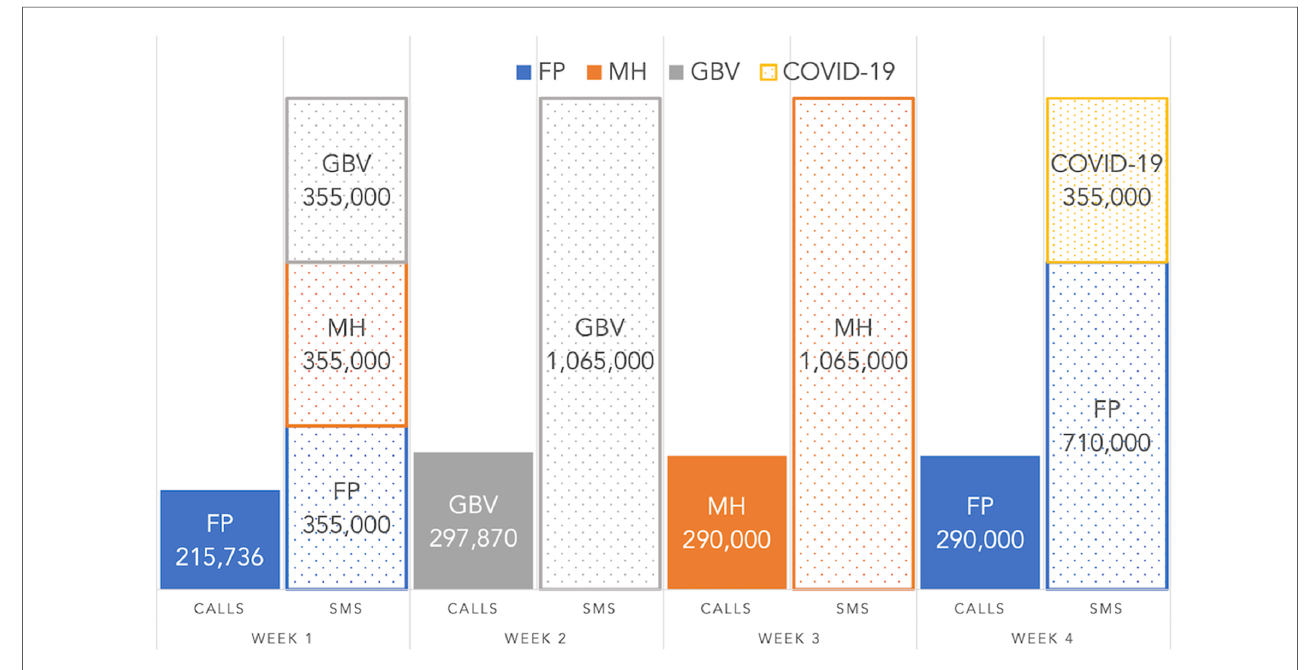
FIGURE 9 Phase one number of initiated calls and SMS messages per thematic area per